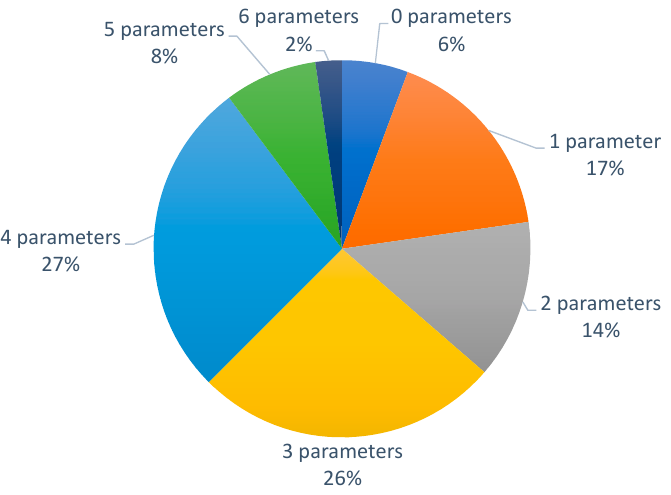
Figure 6. Number of monitored parameters in papers that propose an irrigation system.